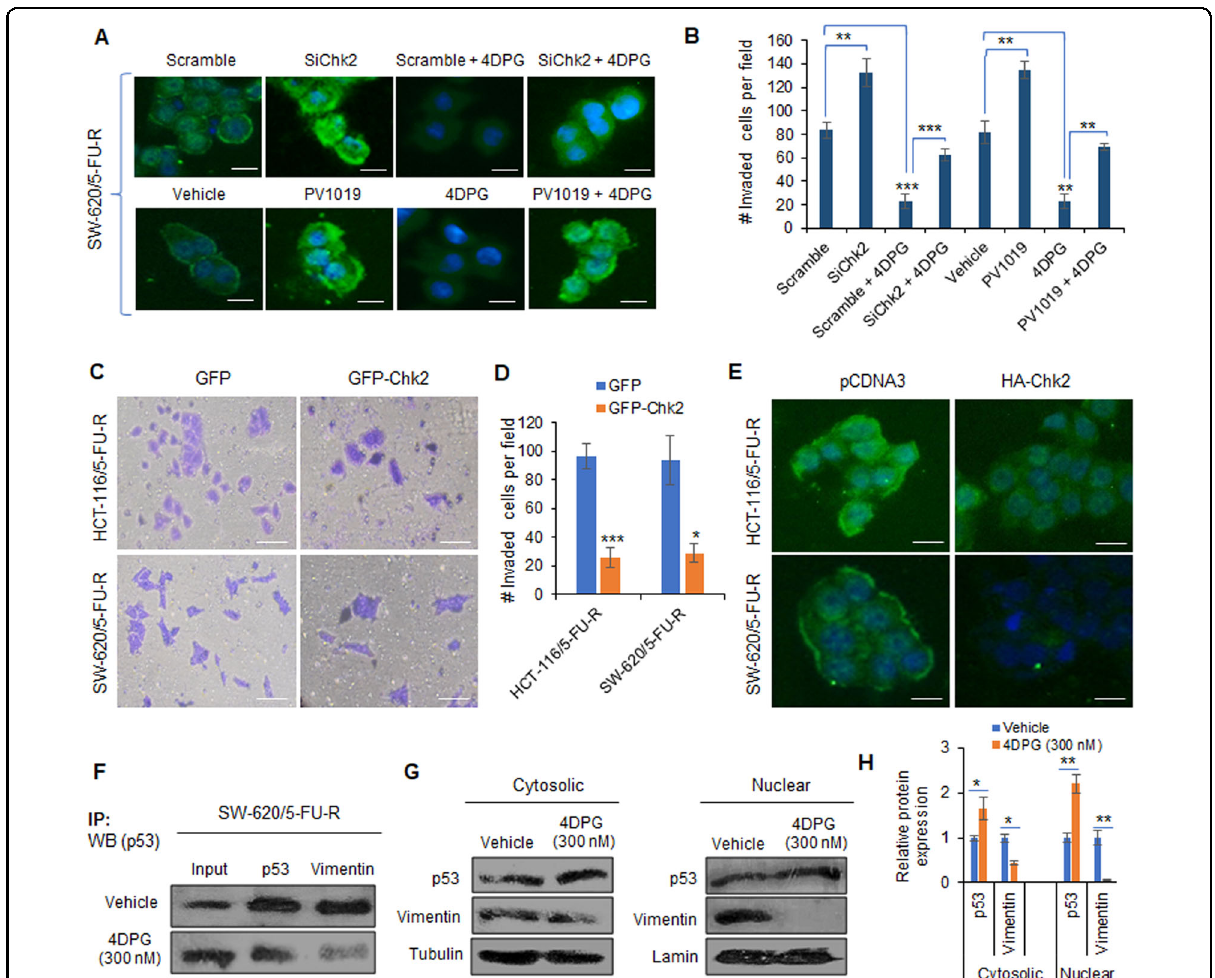
Fig. 3 Chk2-dependent role of 4DPG in modulating p53 and repressing Vimentin expression in 5-FU-R cells. A Immunocytochemistry results showing the Vimentin expression level in SW-620/5-FU-R cells treated/transfected with scramble, SiChk2, scramble plus 4DPG, SiChk2 plus 4DPG, vehicle, PV1019, 4DPG, and PV1019 plus 4DPG for 48 h. Scale bars: 50 µm. B Quanti fi cation of number of invaded HCT-116/5-FU-R cells exposed to the above treatment conditions for 48 h. n = 2, error bars, mean ± SD; ** P < 0.01, *** P < 0.001. C Matrigel invasion assay results showing invaded HCT- 116/5-FU-R and SW-620/5-FU-R cells following 48 h of transient transfection with GFP and GFP-Chk2 plasmid construct. Scale bars: 50 µm. D Quanti fi cation of the number of invaded cells per fi eld from the above experimental conditions. n = 3, error bars, mean ± SD; * P < 0.05, *** P < 0.001. E Immunocytochemistry results displaying Vimentin expression levels in HCT-116/5-FU-R and SW-620/5-FU-R cells after 48 h of transient transfection with pCDNA3 and/or HA-Chk2 plasmid construct. Scale bars: 50 µm. F Immunoprecipitation with Vimentin or p53 followed by western blotting analysis of p53 in SW-620/5-FU-R cells treated with vehicle and/or 4DPG (300nM) for 48 h. G Cytosolic (left panel) and nuclear (right panel) extracts of SW-620/5-FU-R cells treated with vehicle and/or 4DPG (300nM) for 48 h showing protein expression of Vimentin and p53. Tubulin and lamin expression was considered as endogenous loading controls for cytosolic and nuclear fractions, respectively. H Densitometry analysis of the above western blots showing relative protein expression of p53 and Vimentin in cytoplasmic and nuclear extracts. n = 3, error bars: mean ± SD; * P < 0.05, ** P <